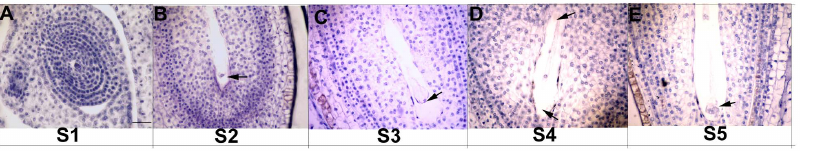
Figure 3. Longitudinal paraffin section images of embryo sac. Arrow in image D shows the abnormal egg cell in embryo sac, arrow in images B, C, and E shows the normal egg cell in embryo sac. Bar in image A is 50 m m, and images B, C, D, and E have the same magnification as image A.